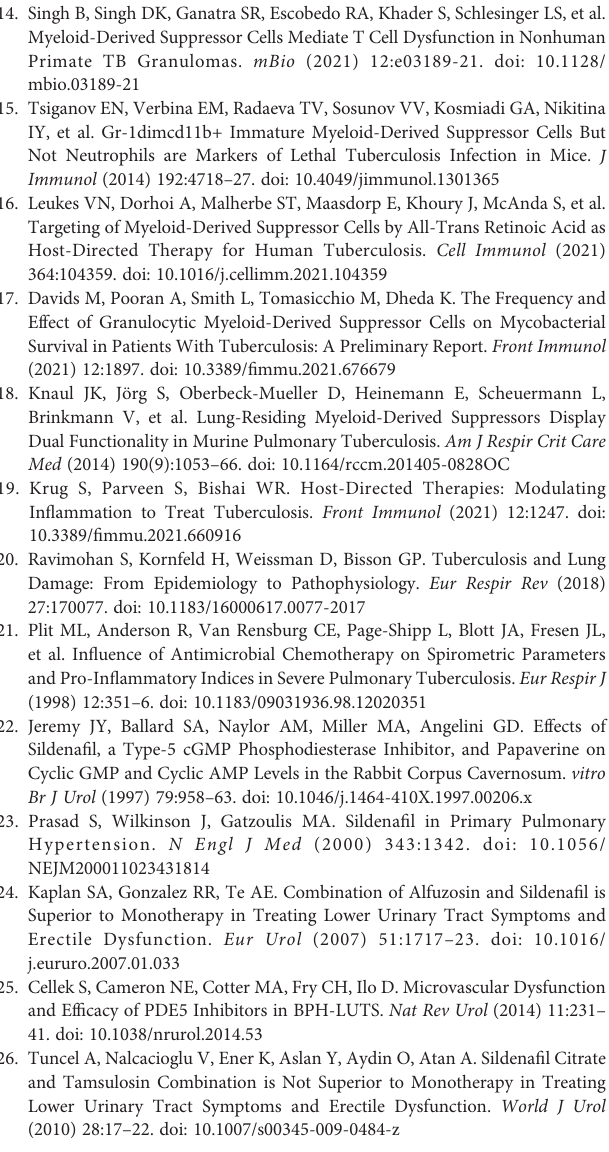
Supplementary Figure 2 | Sildena fi l supplementation does not affect T cell or MDSC cytokine production (PDGFAA, MIP1a, MIP1b, CD40L). Analyte concentration (pg/ml) was measured for various culture combinations (MDSC only, MDSC-T cell coculture, and T cell only), under differing stimulation combinations (Unstimulated and anti-CD3CD28 bead Activation) with or without Sildena fi l treatment, by multiplex analysis. Plots show analyte concentration in culture supernatant. Mixed model analysis, One-way ANOVA with Tukey post-hoc correction Median with interquartile range indicated on plots. P<0.05 was considered signi fi cant.